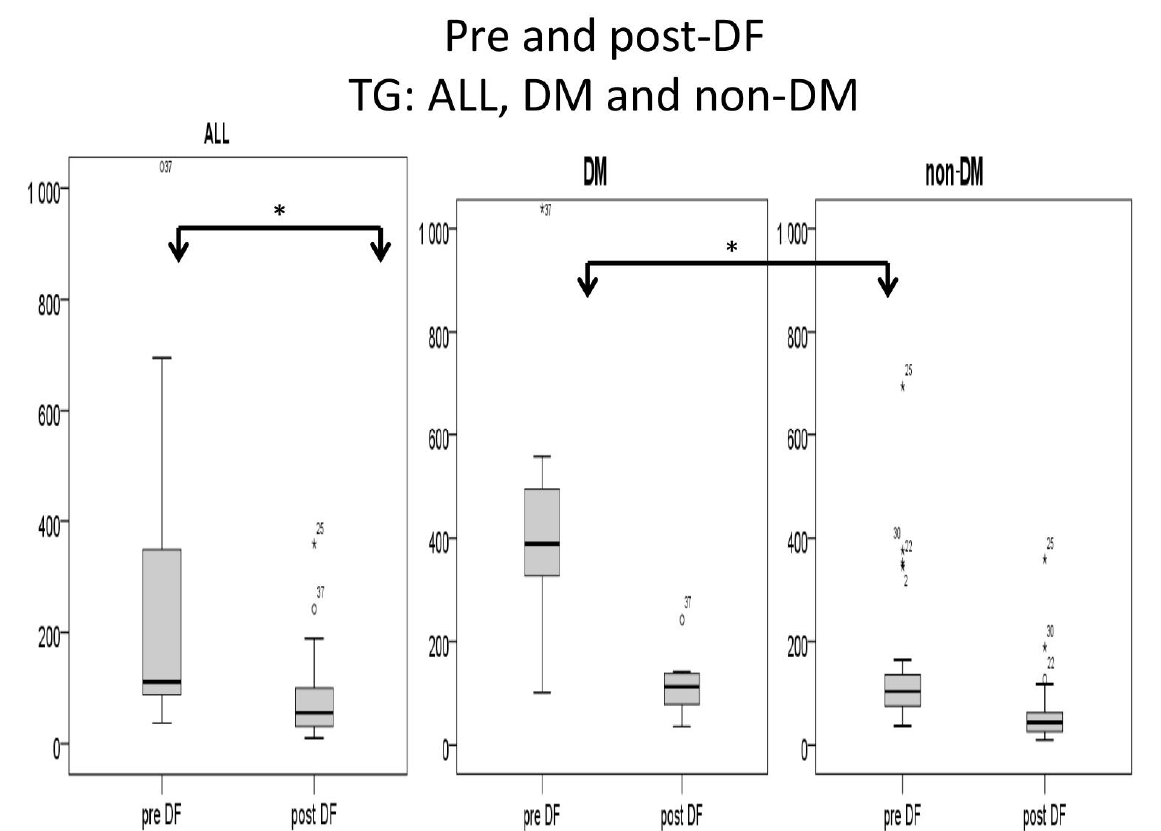
Figure 5. Subgroup comparison of DM and non-DM patients in total cholesterol to HDL ratio. (* for p < 0.05)